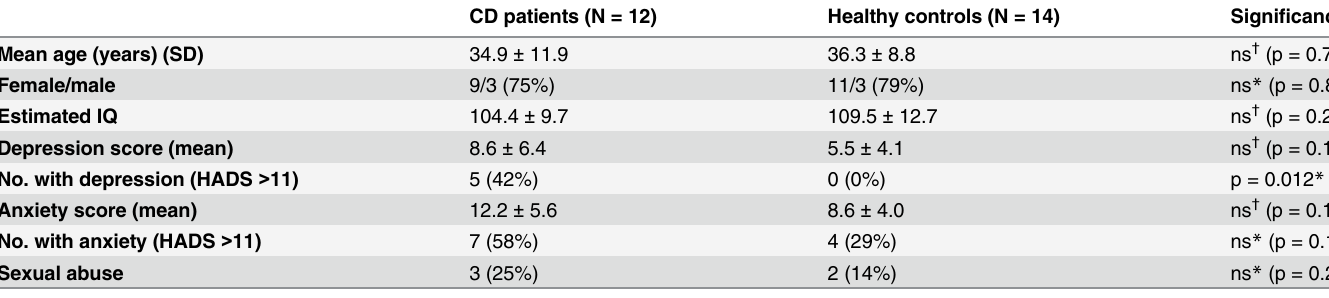
Table 1. Subjects ’